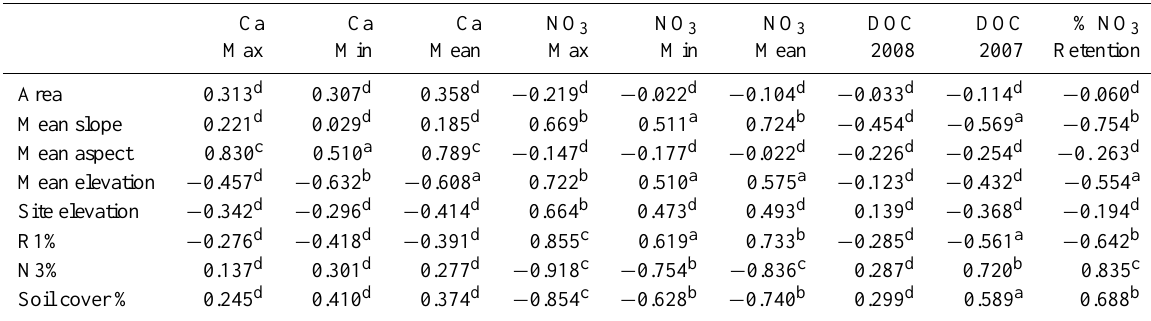
Table 5. Summary of Pearson product–moment correlations between some catchment features and concentration of some chemical species and NO 3 retention (%). Ca Ca Ca NO 3 NO 3 NO 3 DOC